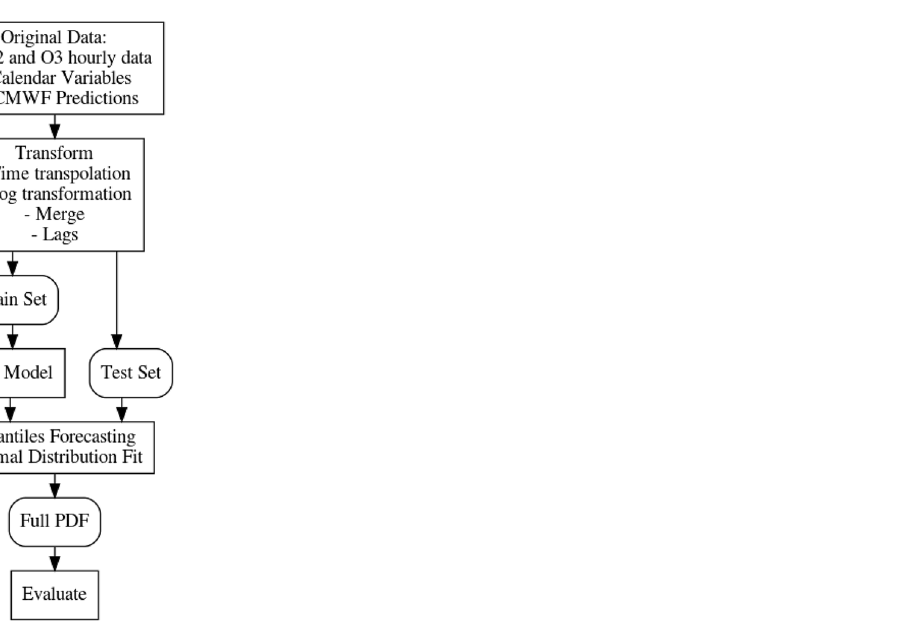
Figure 2. Data flow of the